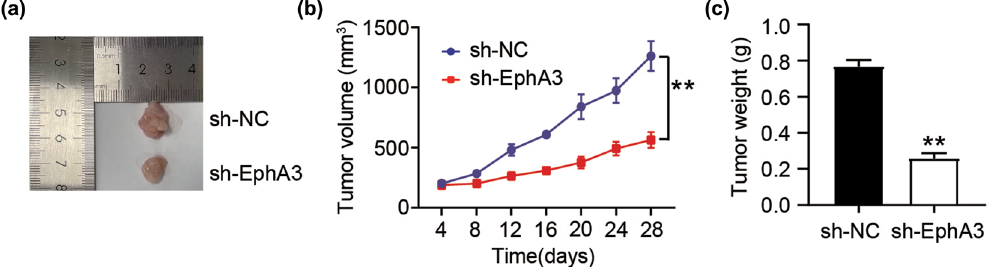
Figure 3: EphA3 silencing attenuates the tumorigenic potential in melanoma in vivo . A375 cells ( 10 7 cells/mouser ) carrying sh - EphA3 or sh - NC were subjected to subcutaneous fl ank injection to mouse ( n = 5 ) . ( a ) Representative pictures of tumor growth. ( b ) Tumor weight was tested every 4 days. ( c ) At 28 h post - injection, the tumors were resected and weight. ** P < 0.01 vs sh -